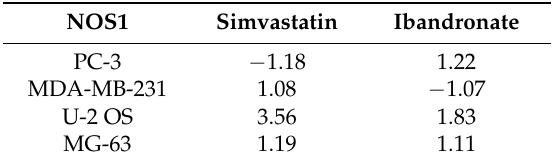
Table 8. Fold regulation of nitric oxide synthase NOS1 .